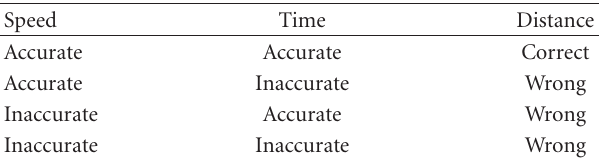
Table 1: Boolean truth table representation for a TOF range finder (binary truth table).